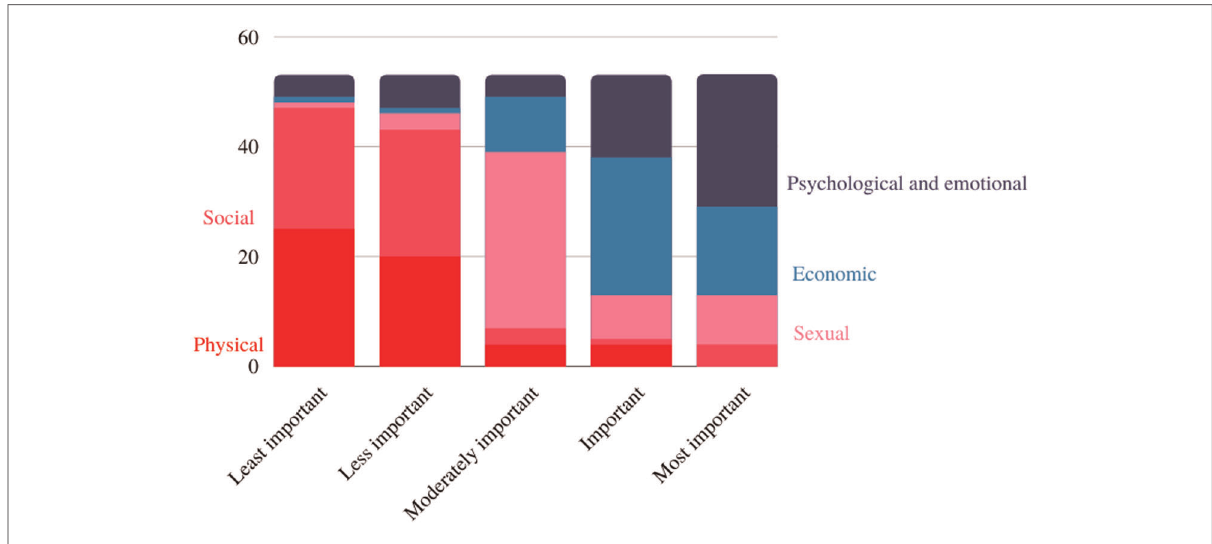
FIGURE 7 The most impacted aspects of